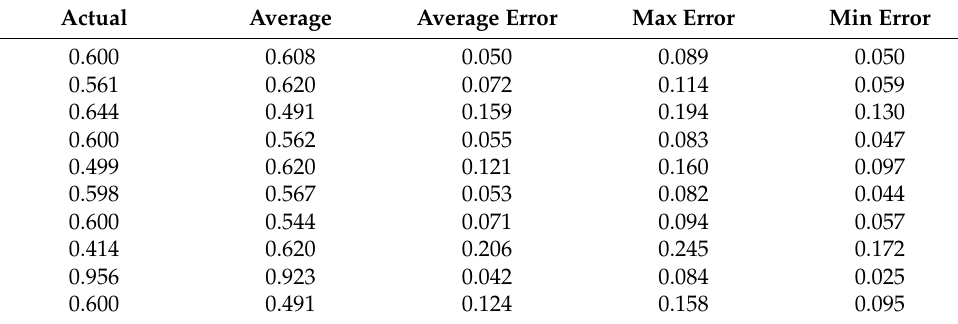
Table A111. Set 2, trials 21–30 data (actual PR